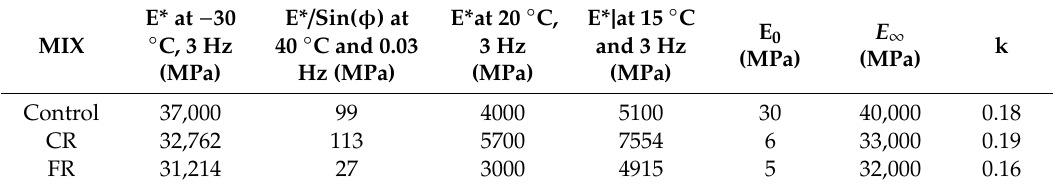
Table 5. The complex modulus properties of the mixes.